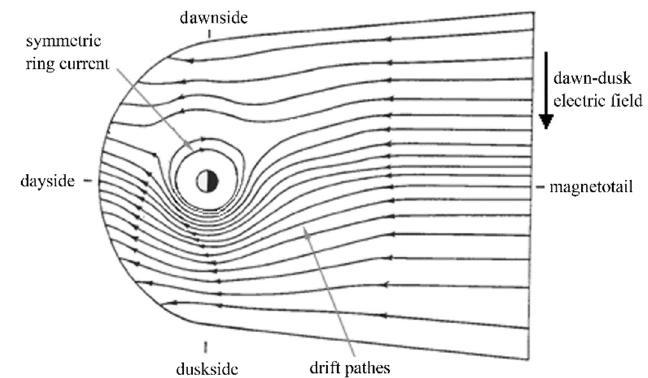
Figure 1. The magnetospheric convection denoted by drift paths of energetic ions. (Figure adapted from Yuting Ng)